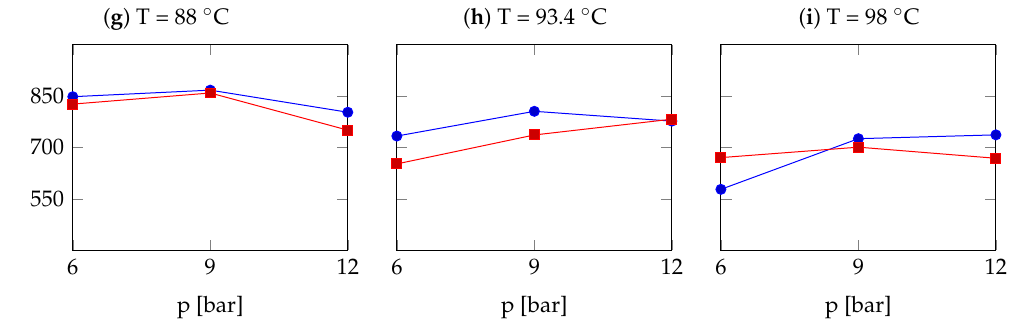
Figure 14. Comparison between the citric acid extracted through numerical simulations (blue profile with circles) and laboratory measurements (red profile with squares), with different inlet water tempera- tures and pressures and different grain size of Robusta coffee powder. Figures ( a – c ) show the results of optimal granulometry, Figures ( d – f ) of coarse granulometry and Figures ( g – i ) of fine granulometry.